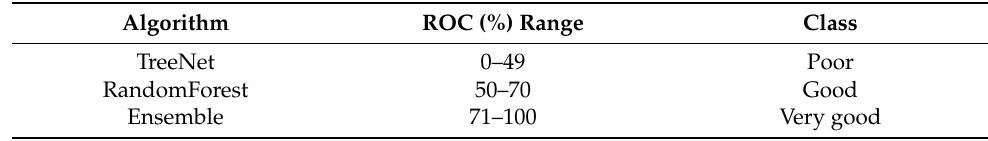
Table 2. Classification table of the models used according to the ROC [55,56].